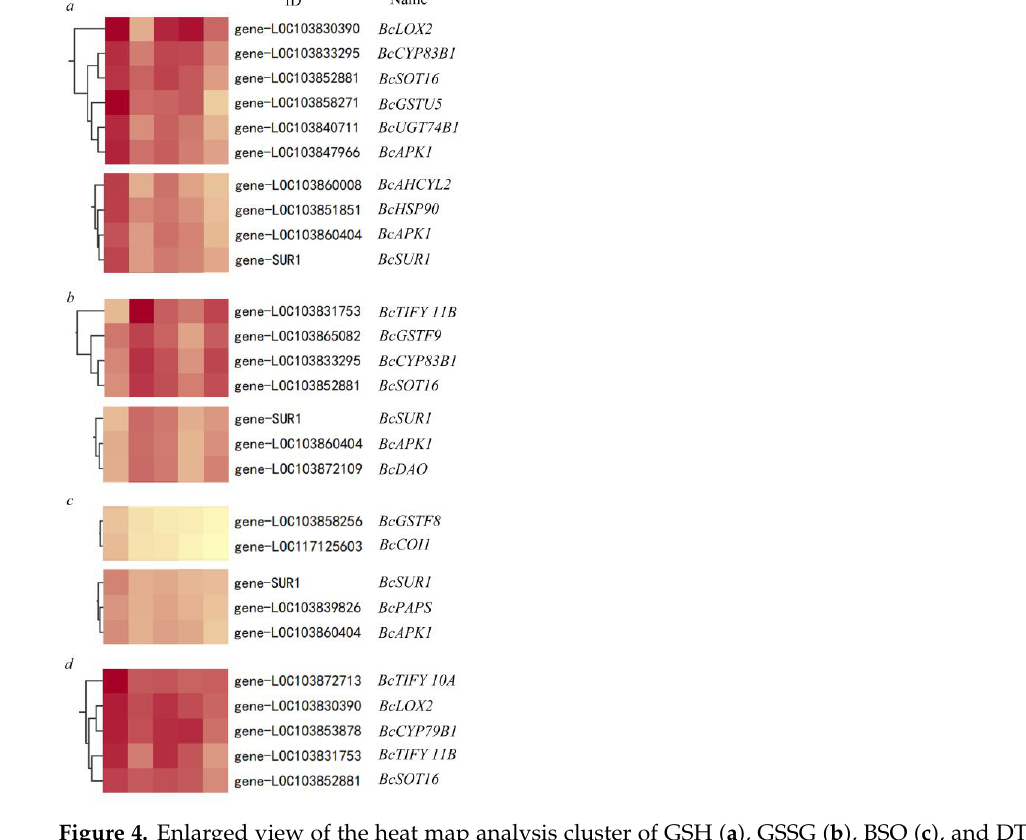
Figure 4. Enlarged view of the heat map analysis cluster of GSH ( a ), GSSG ( b ), BSO ( c ), and DTT ( d ) showing IDs and gene names.